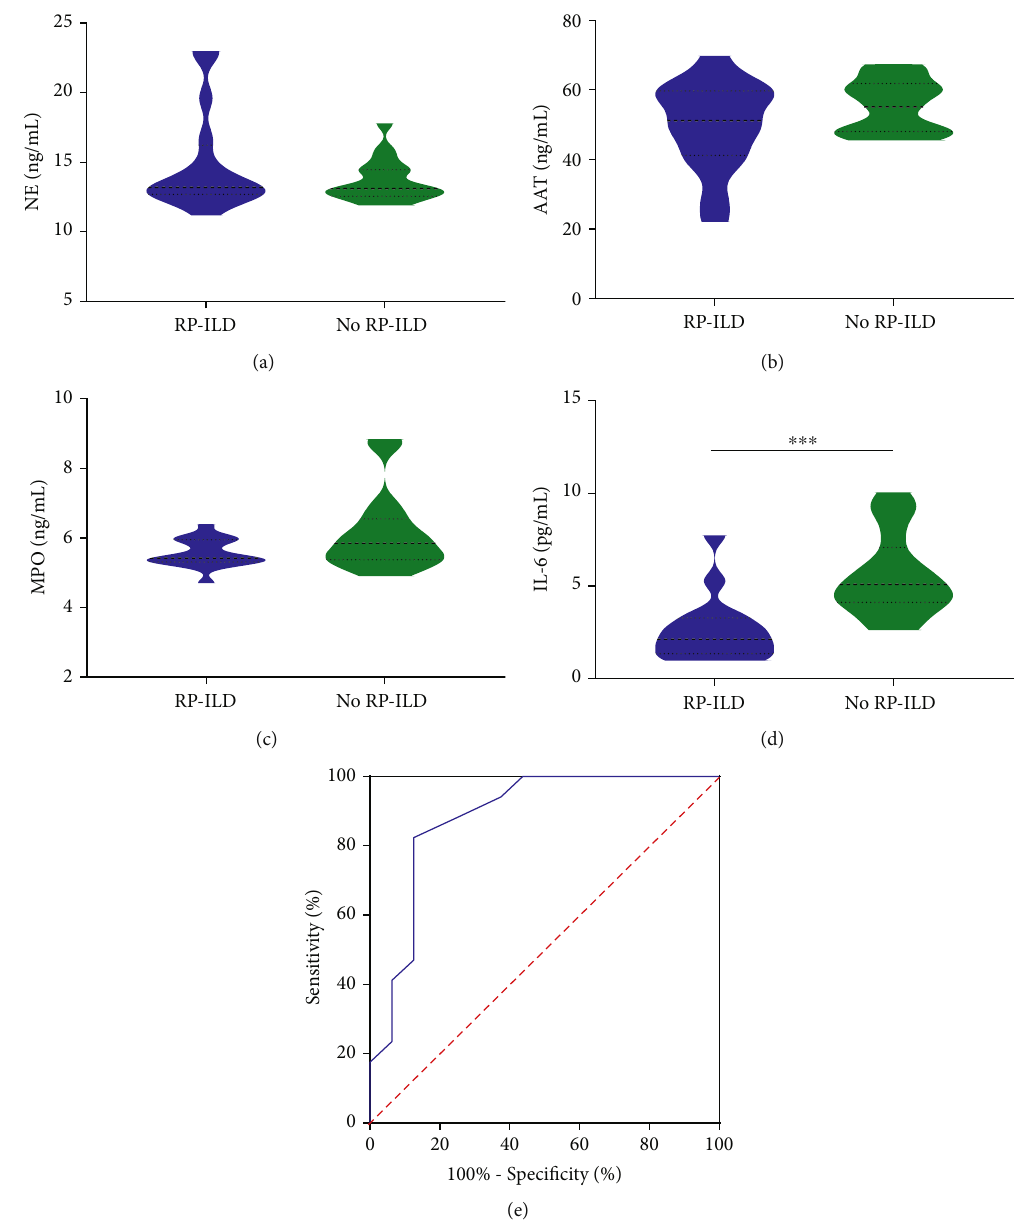
Figure 2: Decreased IL-6 predicted RP-ILD of IIM patients. (a – c) NE ( P = 0 : 226 ), AAT ( P = 0 : 138 ), and MPO ( P = 0 : 067 ) did not di ff er signi fi cantly between patients in the RP-ILD and non-RP-ILD groups. (d) IL-6 ( P = 0 : 0002 ) level was signi fi cantly lower in patients in the RP-ILD group. The results of the IL-6 assay ranged from 0.98 to 7.74pg/mL (the second lowest was 1.31pg/mL). (e) ROC analysis showed that the AUC values of IL-6 at 0.884 (95% CI 0.762 – 1.000, P = 0 : 0002